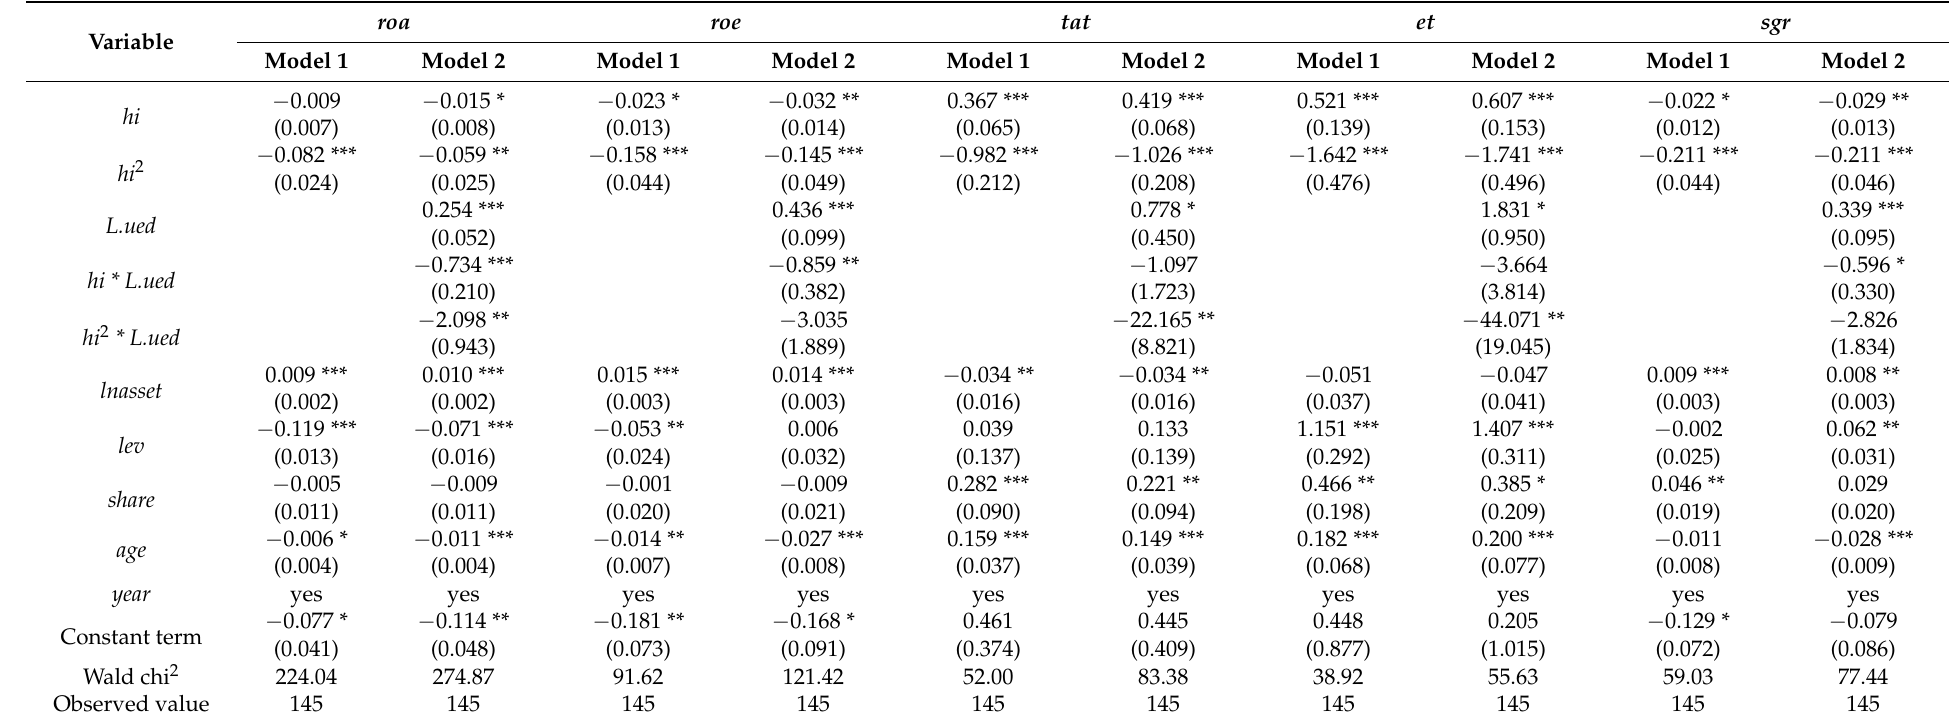
Table 5. DIT, UED level, and operating performance of port